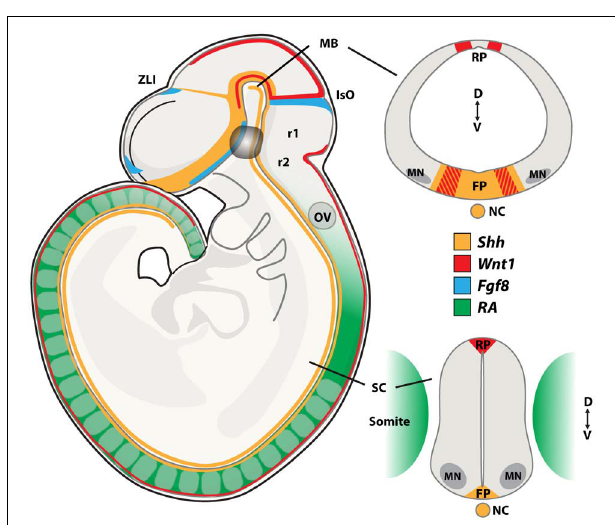
FIGURE 2 | Morphogen signaling during neural tube development. During embryogenesis, neurons present in the midbrain (MB), including dopamine and oculomotor neurons are born at the intersection of the signaling molecules Shh, Wnt1, and Fgf8. Spinal motor neurons (MNs) are patterned by Retinoic Acid (RA) and Shh. Sagital and coronal views at the midbrain and spinal cord levels of the mouse embryo showing the expression patterns of these morphogens. FP, floor plate; IsO, isthmic organizer; MB, midbrain; NC, notochord; OV, otic vesicle; RP, roof plate; SC, spinal cord; ZLI, zona limitans intermedia; r1, rhombomer 1; r2, rhombomer 2; D, dorsal; V, ventral. Adapted from Aguila et al.,